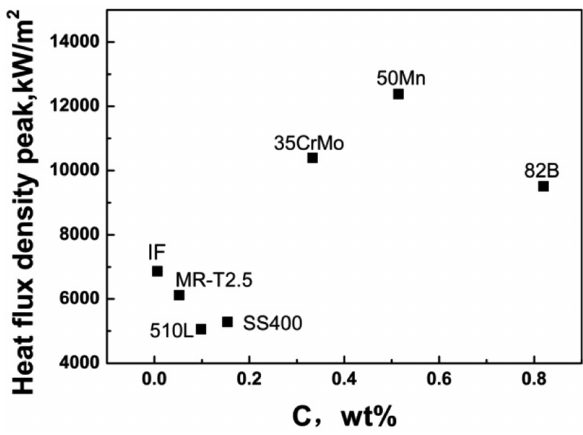
Figure 15: Effect of carbon content on heat flux density